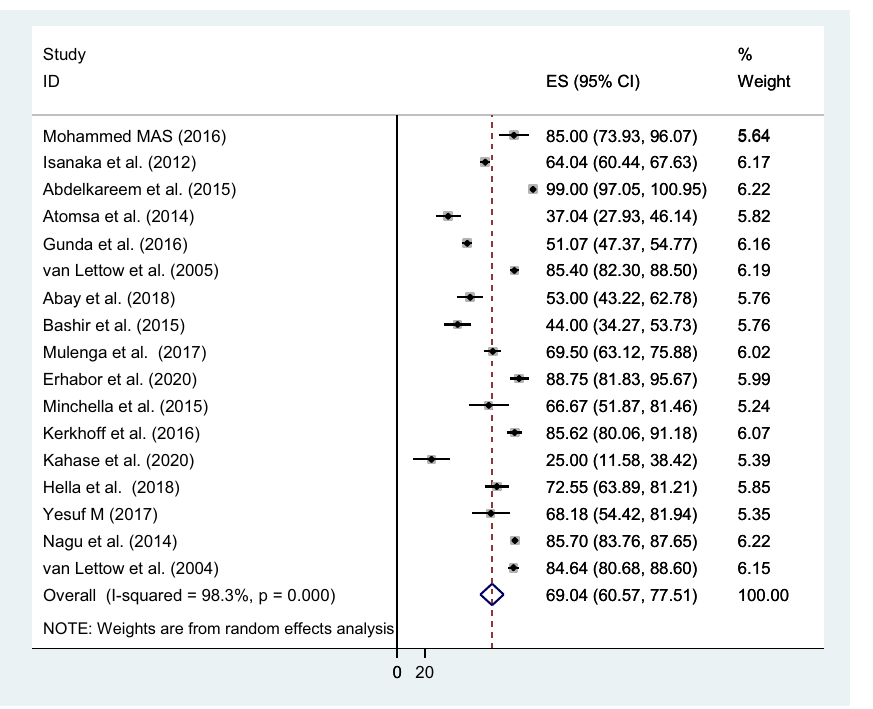
Figure 2. The pooled prevalence of anemia among people with